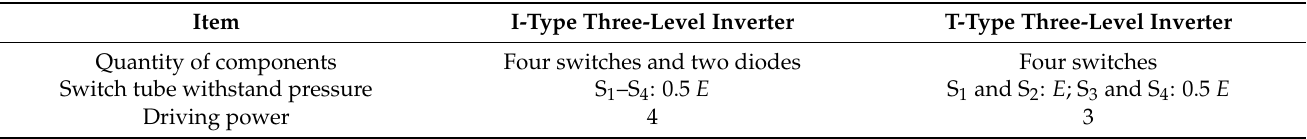
Table 6. Comparison of different three-level